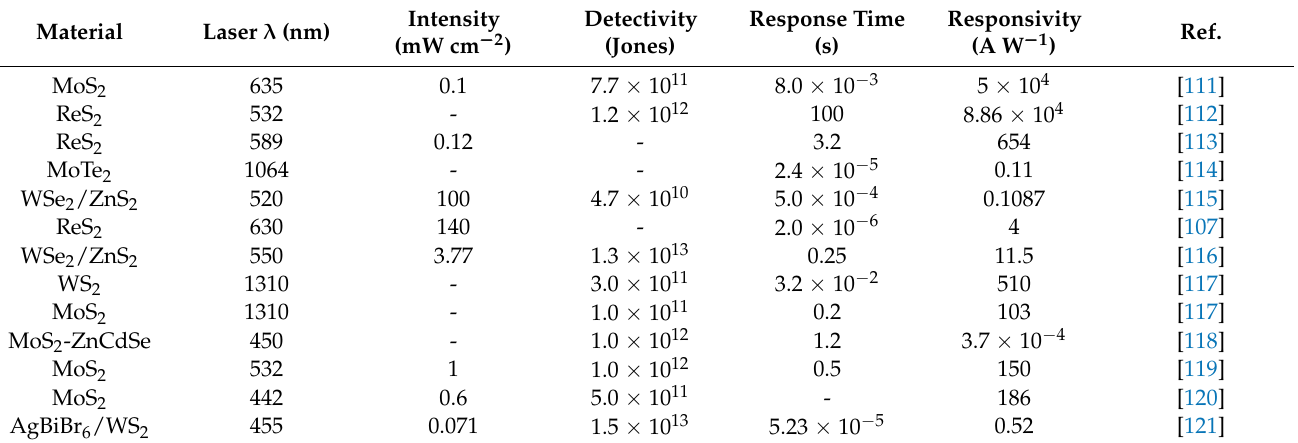
Figure 7. ( a ) Schematic of supported (in contact with back-gate dielectric) channel ReS 2 transistors under 633 nm focused laser excitation; ( b ) schematic of suspended (airgap between channel and back-gate dielectric) channel ReS 2 transistors under 633 nm focused laser excitation (Reproduced with permission from ref. [107]. Copyright 2018 ACS Publications.). Table 2. Photodetectors based on TMDC materials.